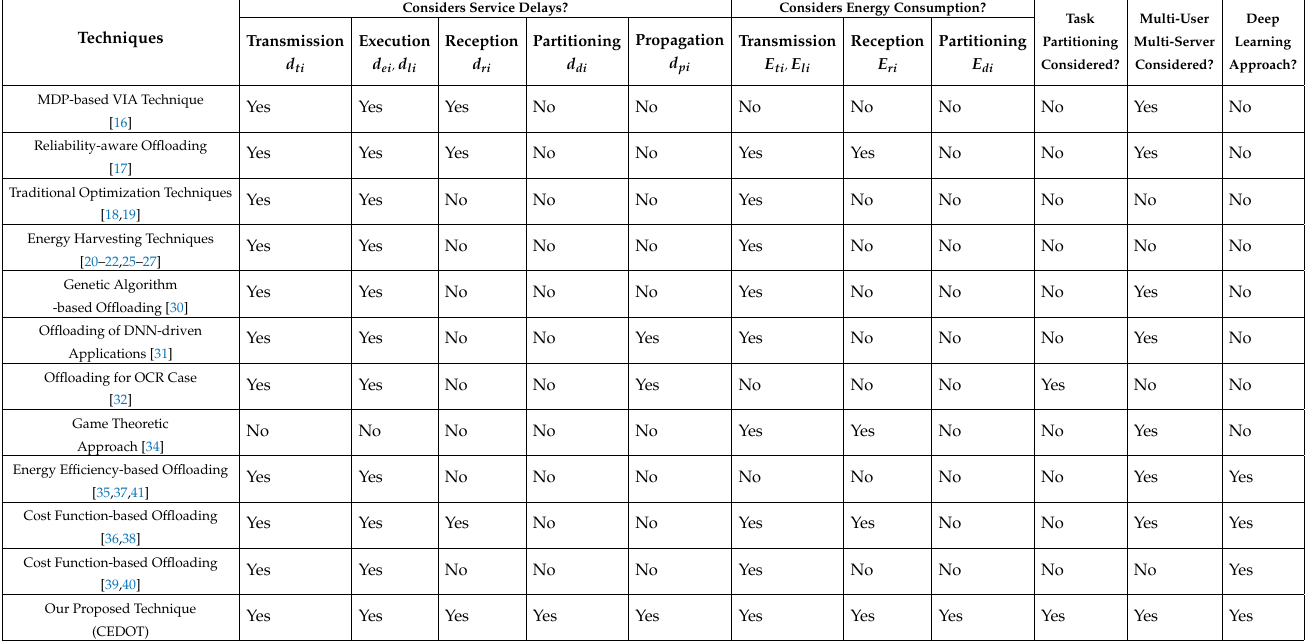
Table 1. Summary of the related